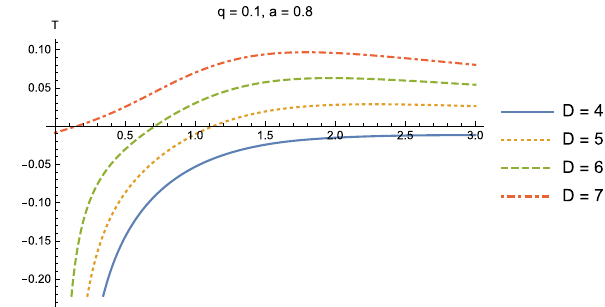
Fig. 15 Hawking temperature in third order Lovelock gravity as func- tion of r h , for a = 0 . 8 and q = 0 . 1